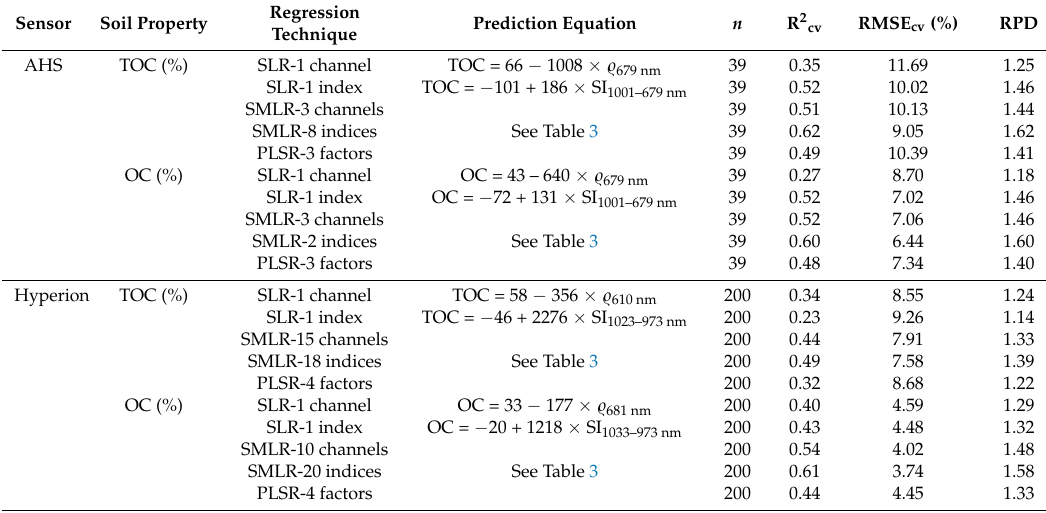
Table 2. Leave-one-out cross-validation statistics of the regression models for soil organic C prediction using AHS and Hyperion